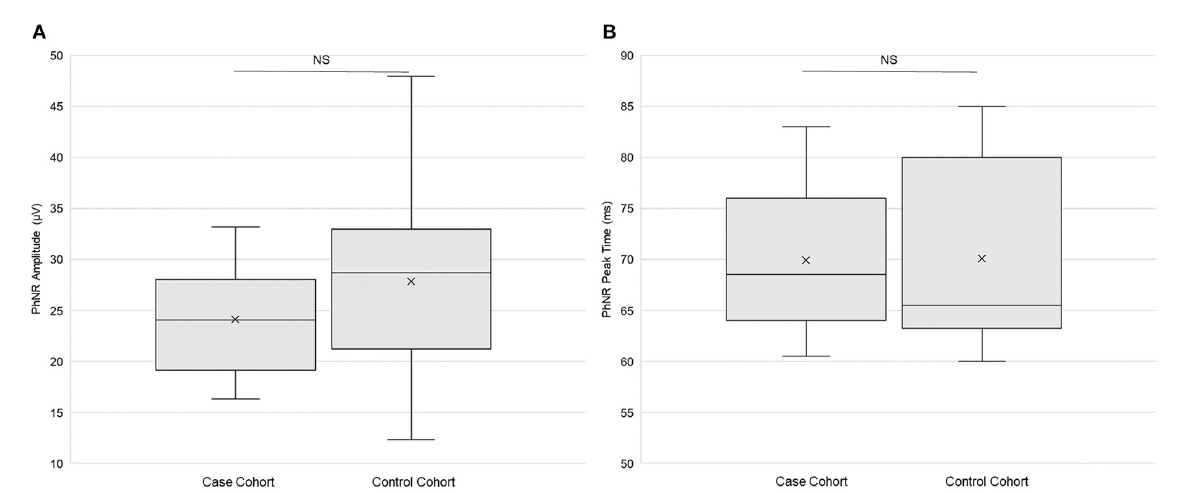
FIGURE4 Electroretinography primary outcomes. (A) Photopic negative response (PhNR) amplitude ( n = 20) and (B) PhNR peak time ( n = 21) in both the case and the control cohorts. Each box represents the interquartile range, and the internal line is the median. The internal “X” is the mean. The whiskers represent the 90th and 10th percentiles. Two case subjects (103 and 114) did not return for the ERG study session, and one control subject (204) did not return. PhNR amplitude data from two case subjects (110 and 122) and from one control subject (210) did not meet quality control standards and were thus omitted. PhNR peak time data from one case subject (122) did not meet quality control standards and were thus omitted. NS is not statistically significant ( p > 0.05, paired t -test).